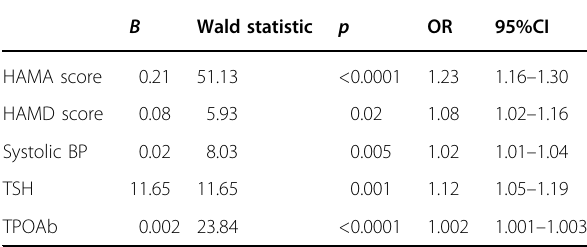
Table 2 Factors associated with suicide attempts in MDD patients with anxiety symptoms.